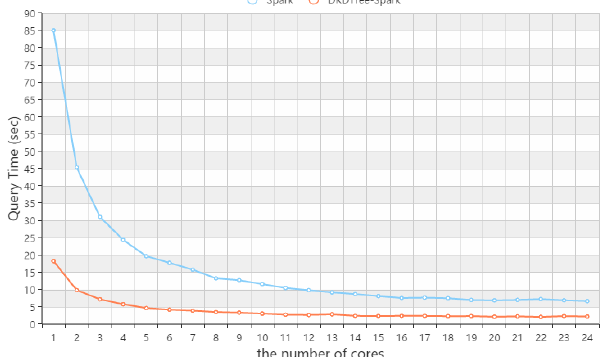
Figure 7. Counting Query with Different Number of Cores As shown in Figure 7, the query time decreases with the number of cores increasing for both Spark cluster with DKD-Tree index and Spark cluster without DKD-Tree index. In Spark cluster node, the greater the number of cores, the more tasks can be executed in parallel. As the Spark cluster has good query performance by adding the number of cluster cores.